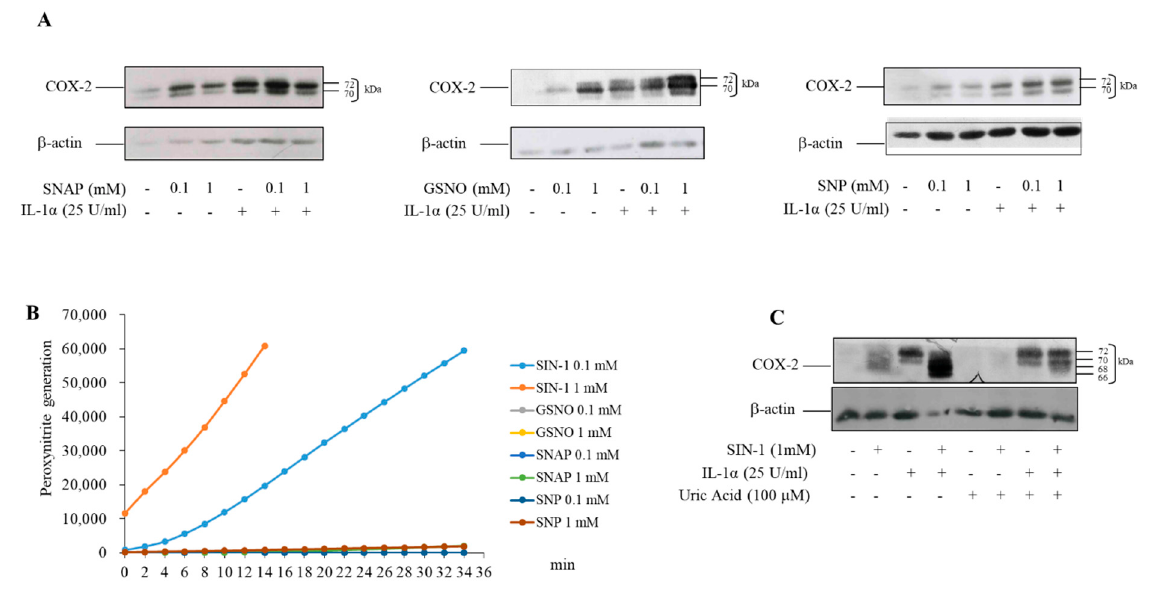
Figure 2. COX-2 expression induced by NO-donors. ( A ) HUVEC were incubated for 18 h with different concentrations of SNAP, GSNO, SNP alone or in combination with IL-1 α . ( B ) The generation of peroxynitrite was monitored by the fluorescence measured at Ex/Em = 490/530 nm using the peroxynitrite assay kit ( C ) HUVEC were preincubated with 100 μ M uric acid for 1 h. Incubation was continued for 18 h after the addition of 1 mM SIN-1. COX-2 expression was evaluated by Western blot analysis. β -actin was used as a control of protein loading. Results are representative of 3 independent experiments.